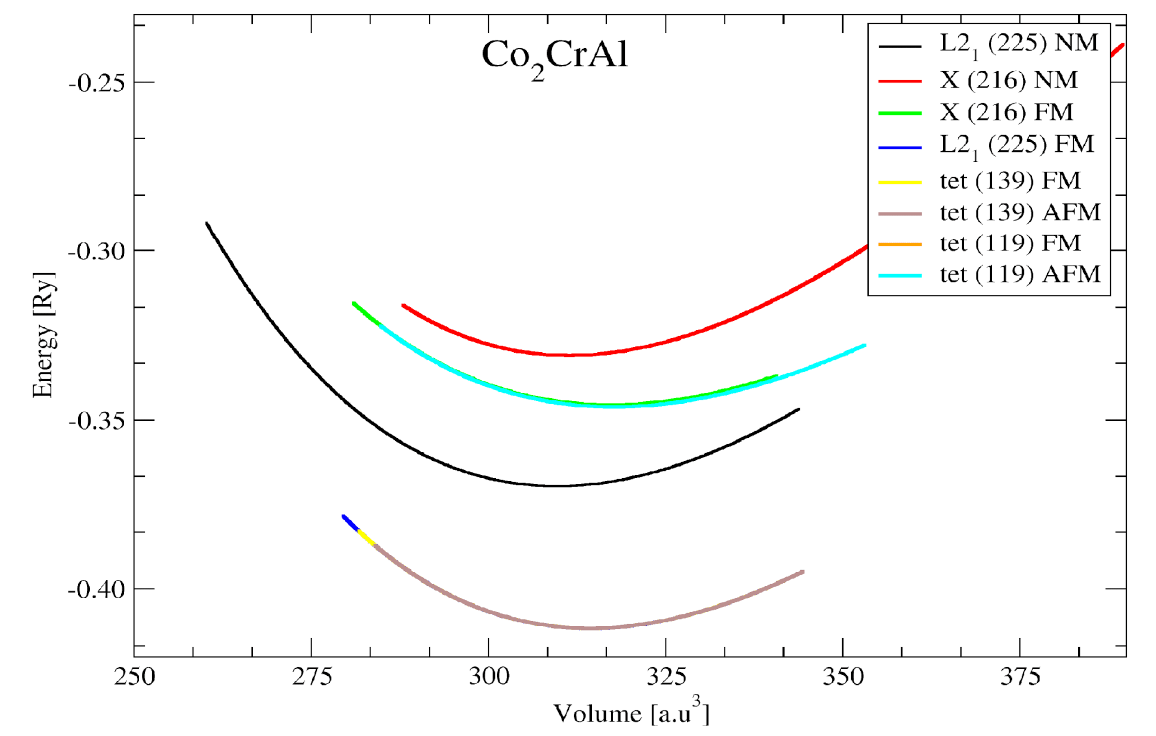
Figure 2. The total energy (Ry) versus volume (a.u. 3 ) for different crystal structures of Heusler Co 2 CrAl.